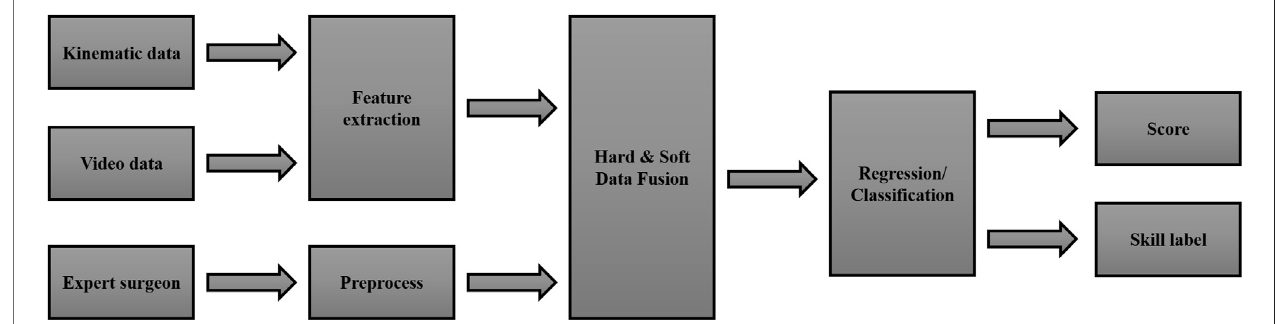
FIGURE 5 | A general framework for surgical skill assessment.